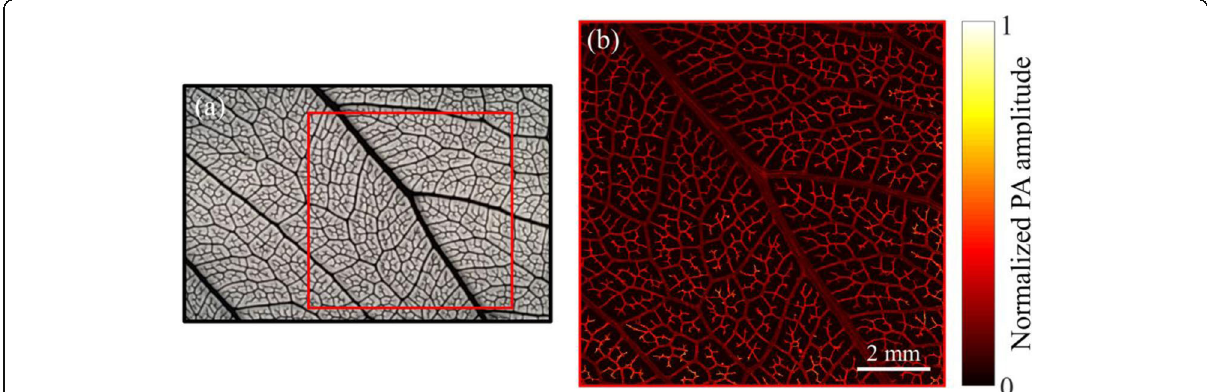
Fig. 3 Leaf phantom imaging. a A photograph of a leaf phantom dyed with black ink; b An LD-based PAM image of the red marked region in Fig.